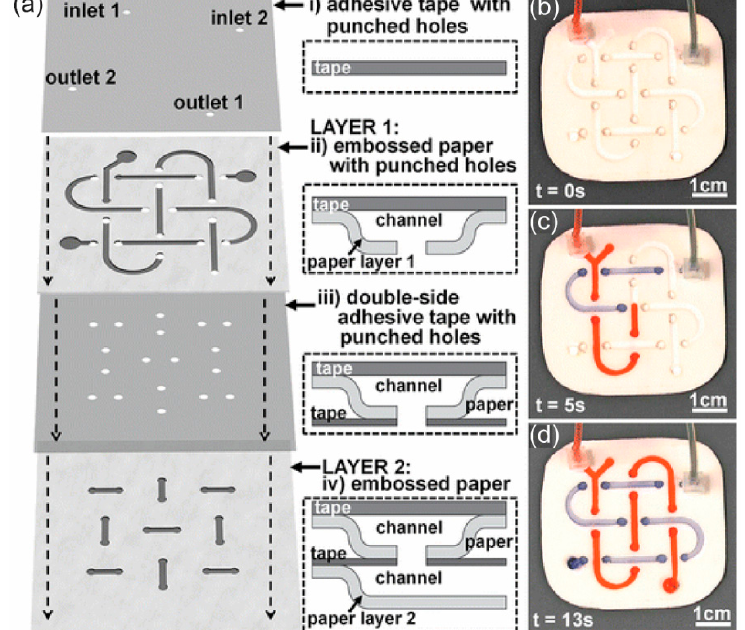
Figure 4. ( a ) Fabrication of a 3D p-CMF device by assembling components such as adhesive tape and embossed paper. ( b ) The fabricated 3D p-CMF device before fluidic loading and ( c ) after 5 s of fluidic loading. ( d ) The flow of the fluid at the ends of the channels. Reprinted with permission from the authors of [48]. Copyright 2014 American Chemical Society.